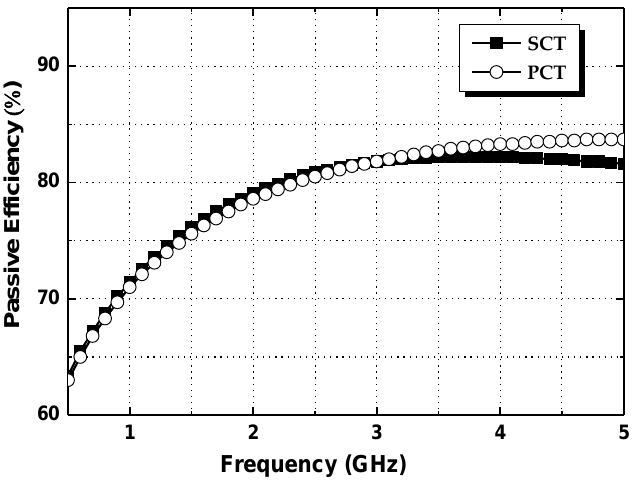
Figure 6. Simulated efficiency characteristics of SCT and PCT.